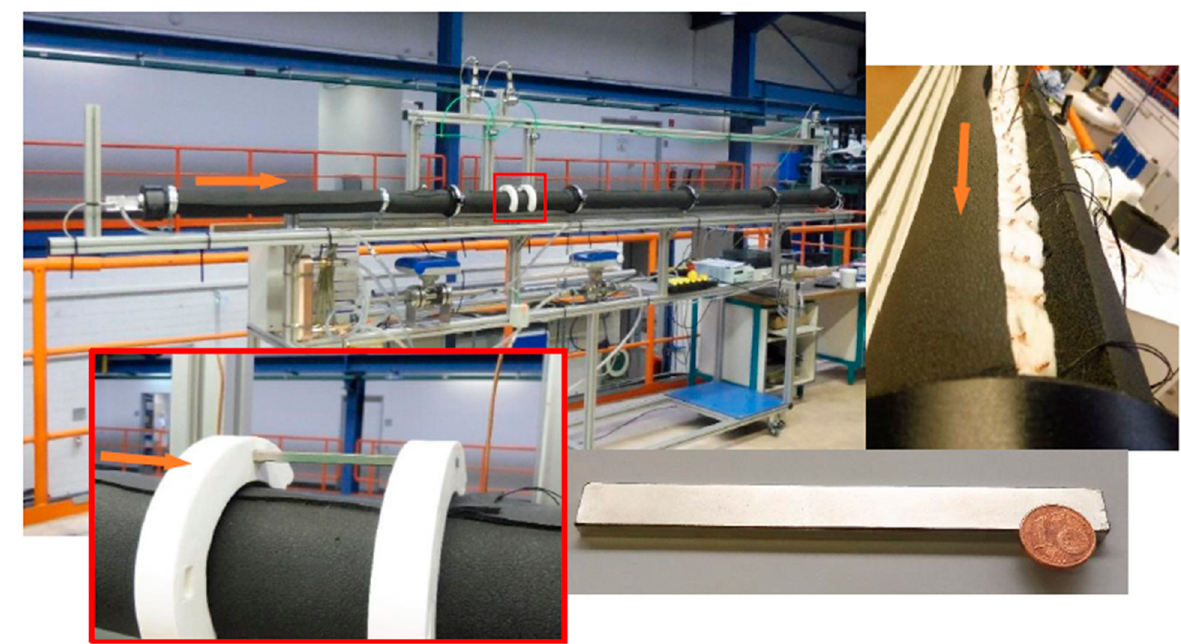
Figure 1. Test rig. Clockwise starting from the upper left photo: general view before closing the insulation (white: glass fibre mat, black ArmaFlex shell, wires from Pt100), NdFeB magnet, and magnet holder (single magnet above the pipe, r cl = 55 mm). Orange arrow indicates direction of flow. The blue-framed area of the magnet (lower right photo) indicates one pole area. The other pole area is opposite (the area on which the magnet lies).